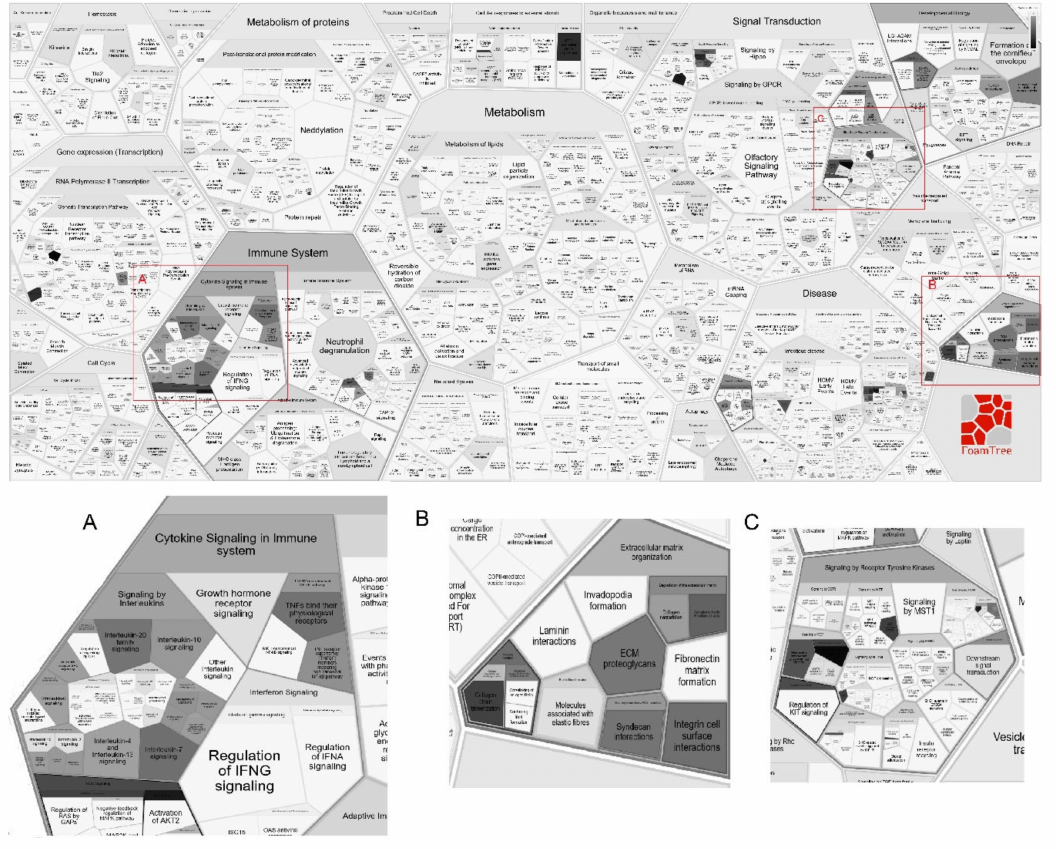
Figure 4. Reacfoam shows a high-level pathway overview of the genes reported in the selected studies. Significantly enriched pathways are shown in dark shade. The three main pathways have been zoomed in as ( A ) cytokine signaling in immune system, ( B ) extracellular matrix organization, and ( C ) signaling by receptor tyrosine